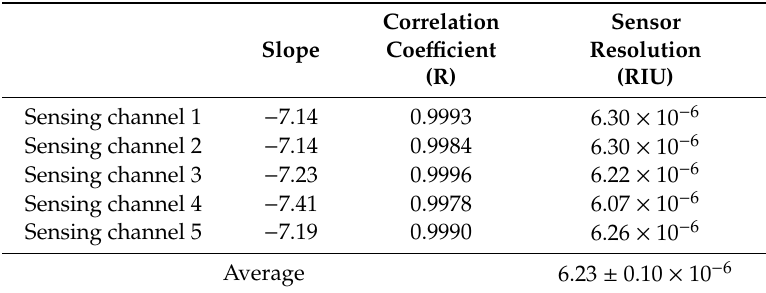
Figure 6. ( a ) Simultaneous temporal responses of all the sensing fibers present in the multi-microchannel FOPPR sensor after serial injection of samples with increasing refractive index; ( b ) calibration curves of sensor response vs. refractive index for the multi-microchannel sensing system. Table 1. Performance of the multi-microchannel FOPPR system in the detection of sucrose solution with various refractive indices.